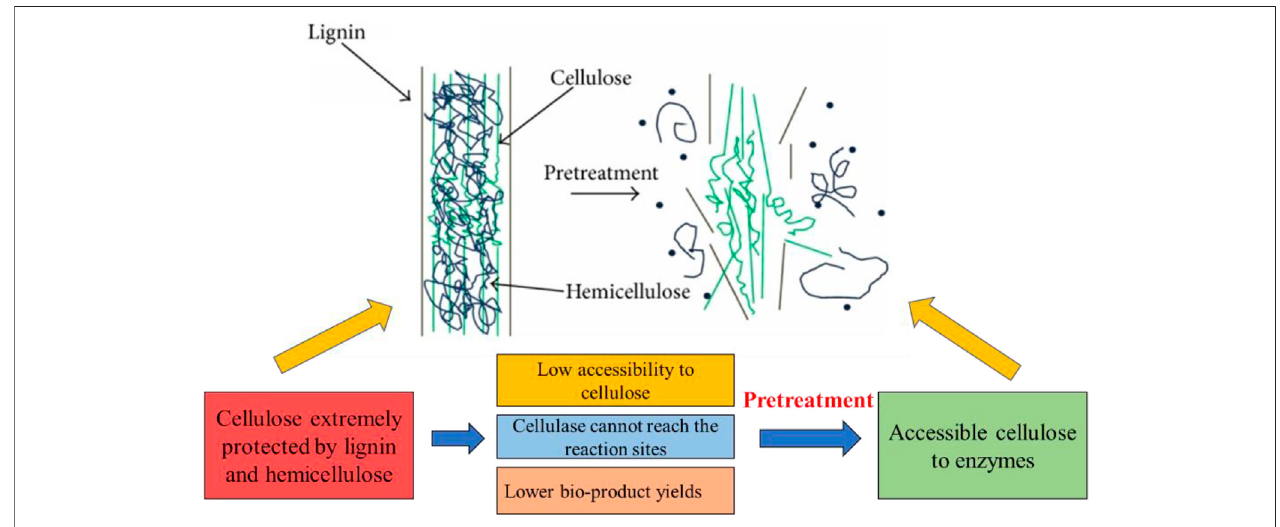
FIGURE 3 | Schematic illustration of biomass pretreatment. Reproduced with permission from Lee et al. (2014).